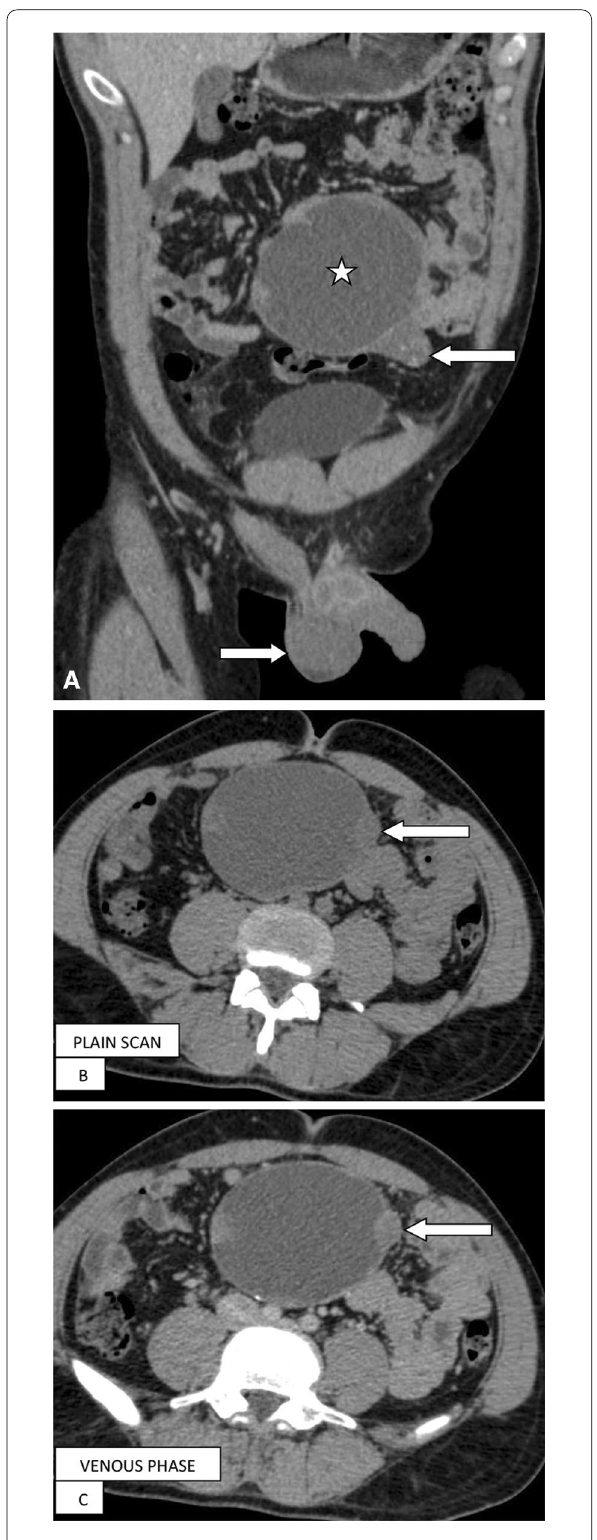
Fig. 3 Coronal ( A ) CT section shows: Right testis is normal in size and position (right arrow). A relatively well defined heterogenous soft tissue density structure of size 3 2 cm is noted in the peritoneal × cavity (left arrow), in the infraumbilical region, to the left of midline, superior to the urinary bladder. Multiple calcific foci were noted within—The soft tissue density structure most probably represents the left atrophic undescended testis. Large complex cystic lesion (star) with multiple focal enhancing soft tissue densities arising from the left undescended testis-s/o malignant etiology. B , C Axial contrast enhanced CT sections show a large well defined cystic lesion of size 8.5 7.4 cm is noted arising from the undescended testis. Multiple × focal enhancing soft tissue densities noted in the inner aspect of the cyst wall. Multiple calcific specks noted in the posterior aspect of cyst wall. This is suggestive of